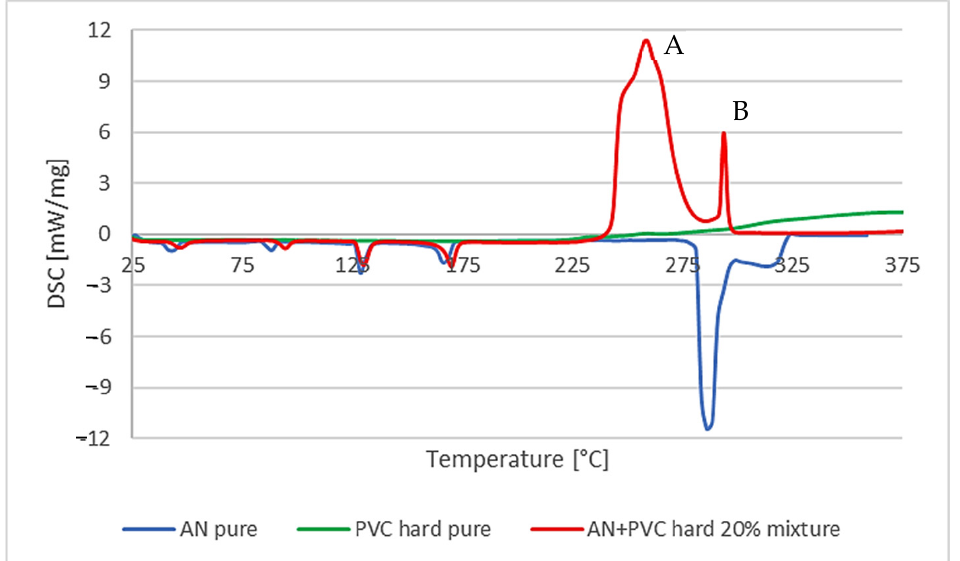
Figure 2. DSC analysis of pure ammonium nitrate (AN), pure hard PVC (uPVC), and their mixture (20%), heat rate 10 °C/min. Enthalpy of the mixture decomposition process Δ H A = − 1384 J/g, Δ H B = − 66 J/g (values of A and B reactions are given in Table 1).